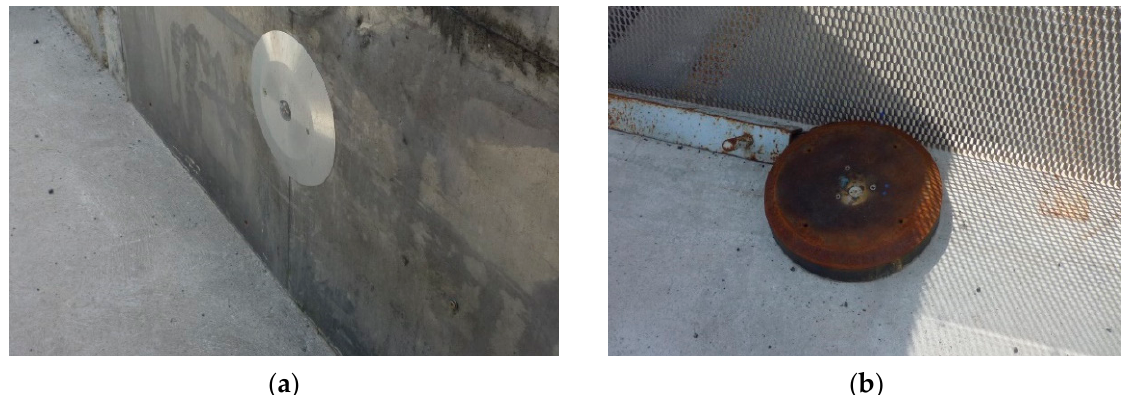
Figure 6. View of the experimental setup showing the one-grid configuration: the grid position, concrete blocks and gauge in front of the grid.